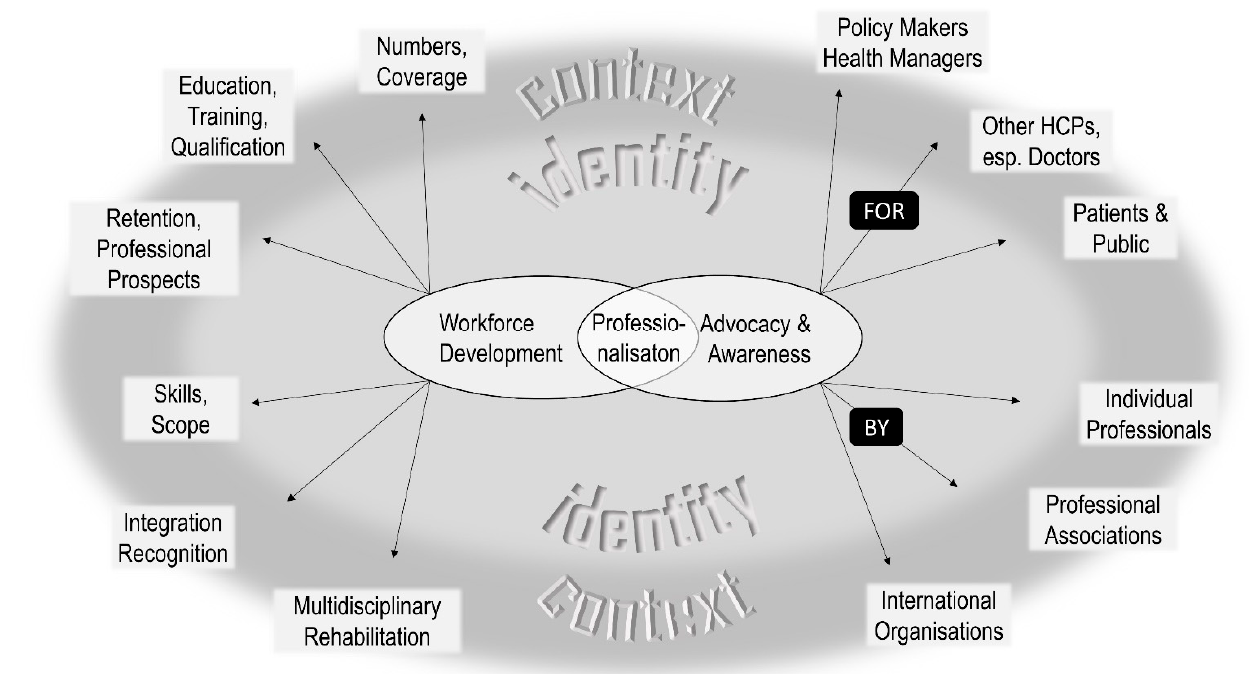
Figure 2. Subthemes and Elements. The key subthemes under the theme ‘Professionalisation’ were ‘Workforce Development’ and ‘Advocacy and Awareness Raising’. These two subthemes contain further divisions into 6 elements each. HCPs = health care professionals.